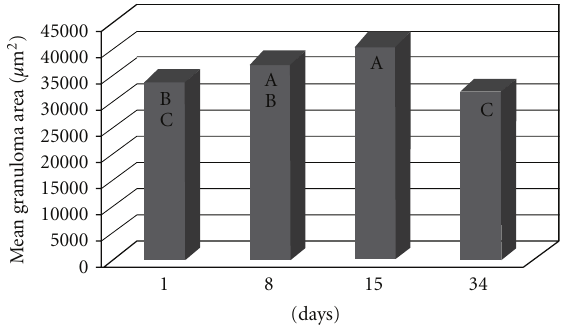
Figure 9: The granulomatous area in the liver of the mice that were previously infected with the S. mansoni BH strain and then inoculated 8 weeks later with eggs from the S. mansoni BH (Group III) or SJ (Group IV) strains. The mice were euthanized 1, 8, 15, or 34 days following inoculation with the eggs. The means depicted with the same letter do not di ff er significantly ( α = 0 . 05).